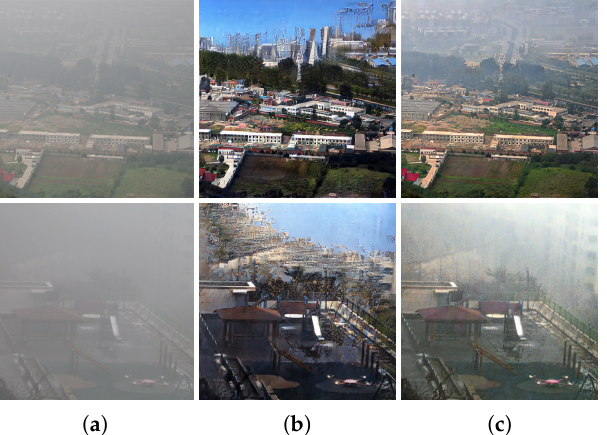
Figure 1. ( a ) Real severely fogged images; ( b ) defogging with a state-of-the-art unpaired approach [7]. Note the clear artifacts in the sky; ( c ) the results produced by the proposed CurL-Defog, denoting a good compromise between image enhancement and fidelity to the original scene. Images are better viewed if enlarged on a computer